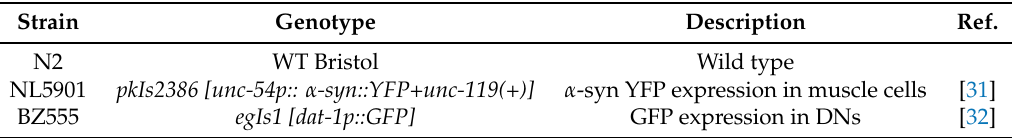
Table 1. Caenorhabditis elegans strains used in this